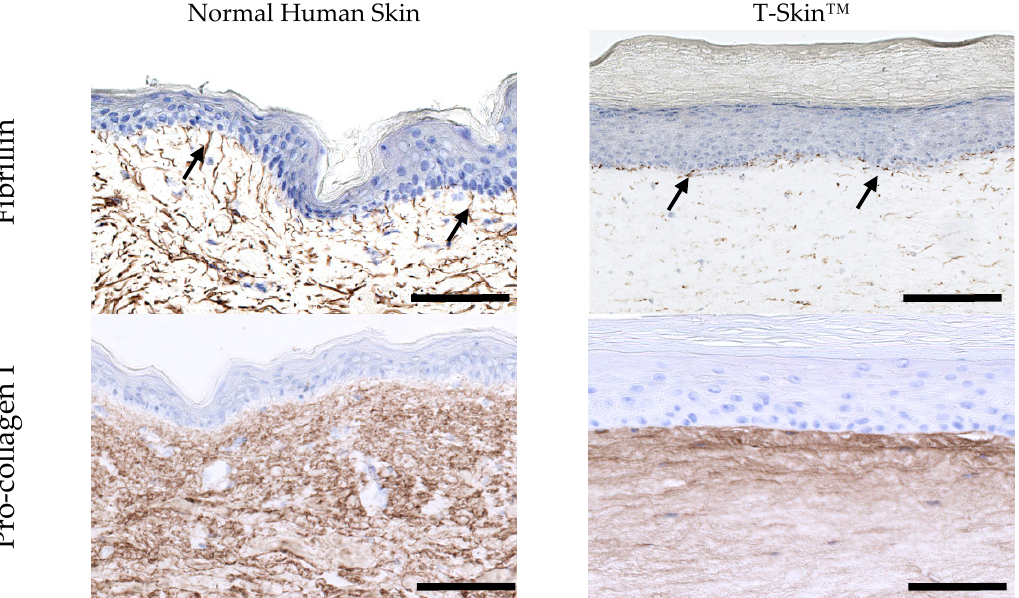
Figure 4. Characterization of the dermis of NHS and T-Skin™. Immunohistochemistry of fibrillin 1 and pro-collagen I was performed using on paraffin sections. Arrows indicate the localization of the specific labelling. Bars = 100 µm.